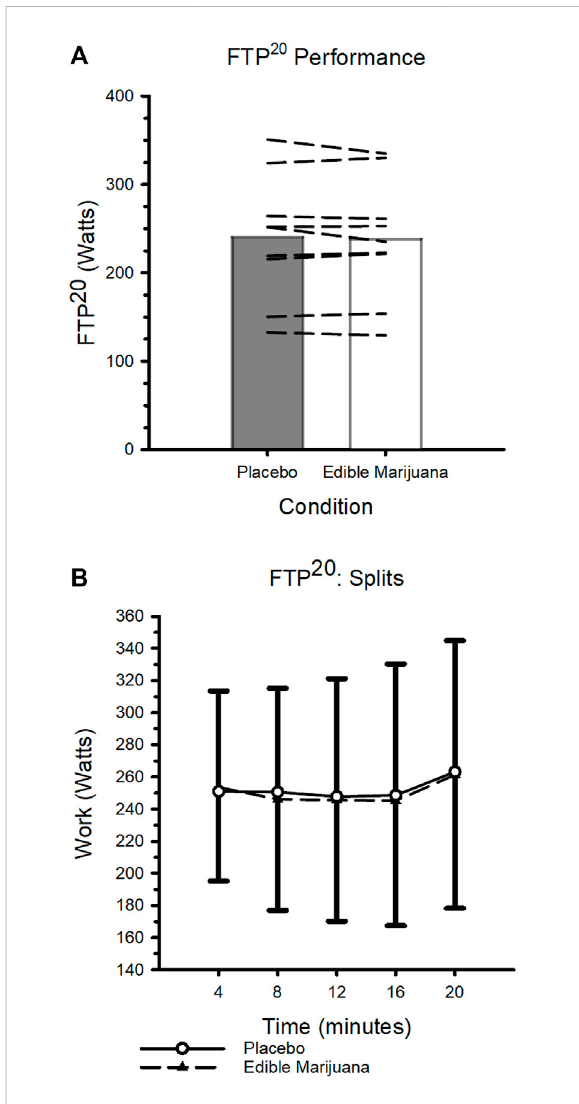
FIGURE 4 FTP 20 Performanceafteringestionofediblemarijuana(10 mg THC) or placebo (A) Maximal sustained mean power output. Bars represent mean data; dashed lines represent individual responses. p = 0.454. (B) FTP 20 performance depicted over 4-min intervals. Data are presented as mean ±